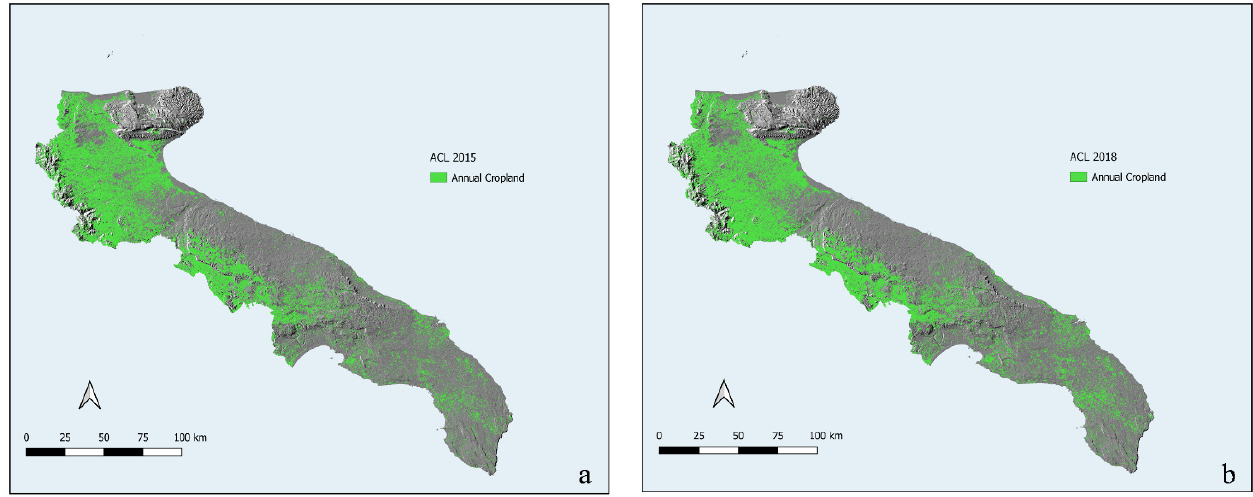
Figure 2. Annual cropland of the Apulia region in ( a ) 2015 and ( b ) 2018. Hill shade calculated using NASA DEM 30 m (https://lpdaac.usgs.gov/products/nasadem_hgtv001/, accessed on 1 November 2021).